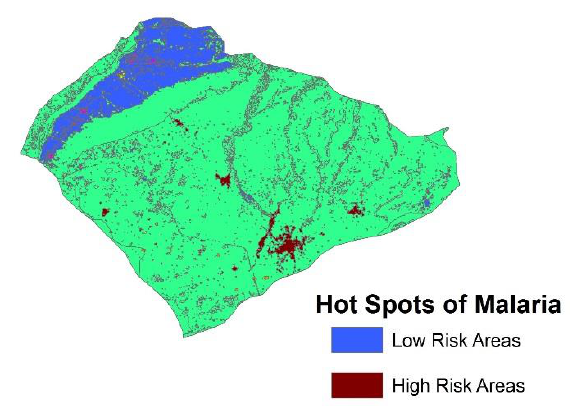
Figure 2. Dark red areas shows the hotspots for malaria based on given factors on risk